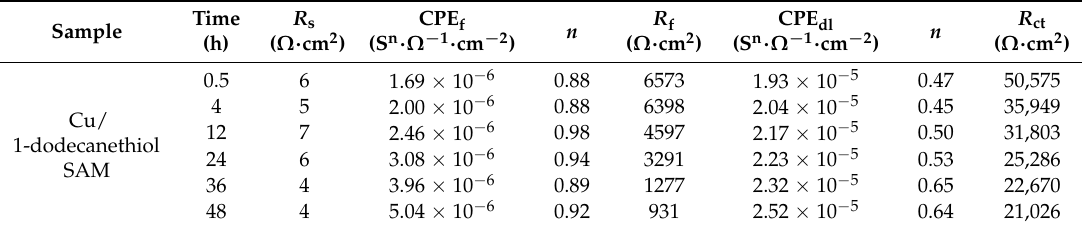
Table 5. Electrochemical impedance parameters of bare copper electrode. Sample Table 6. Electrochemical impedance parameters of copper electrode with 1-dodecanethiol SAM. Sample